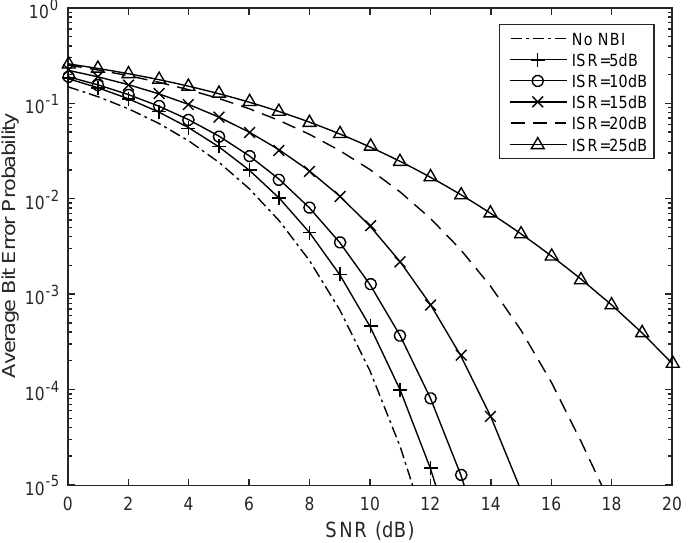
Figure 6. Average bit error probability of the TH-pulse position modulation (PPM) UWB wireless sensors in the unfaded scenario with the narrow band interferences under different power levels.